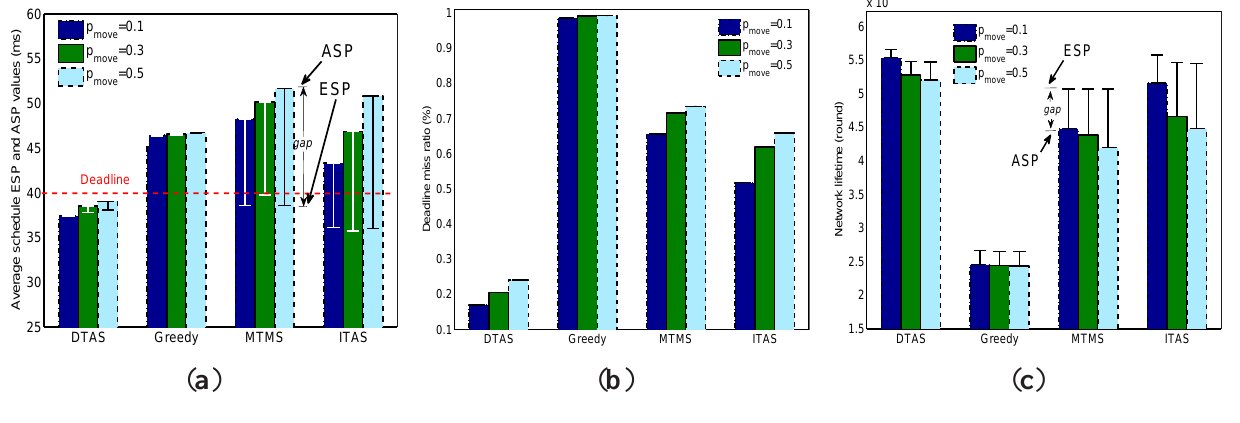
Figure 10. Comparison of algorithm adaptability to network dynamics. ( a ) Schedule length, Expected System Performance (ESP) vs . Actual System Performance (ASP); ( b ) Deadline miss ratio, ASP; ( c ) Network lifetime, ESP vs .